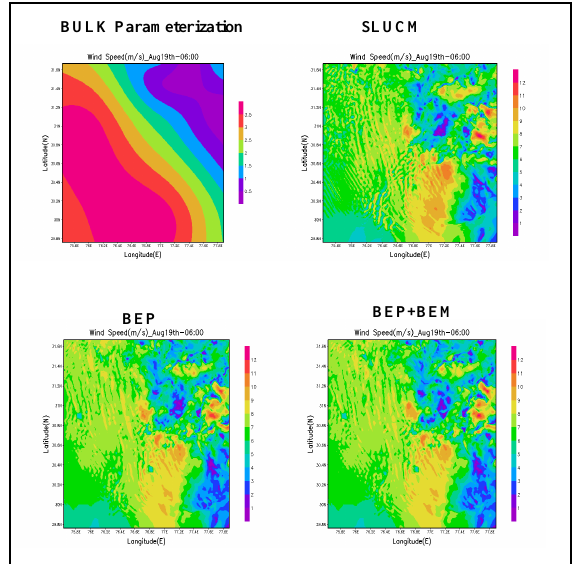
Figure 5. Spatial distribution of Wind Speed with four